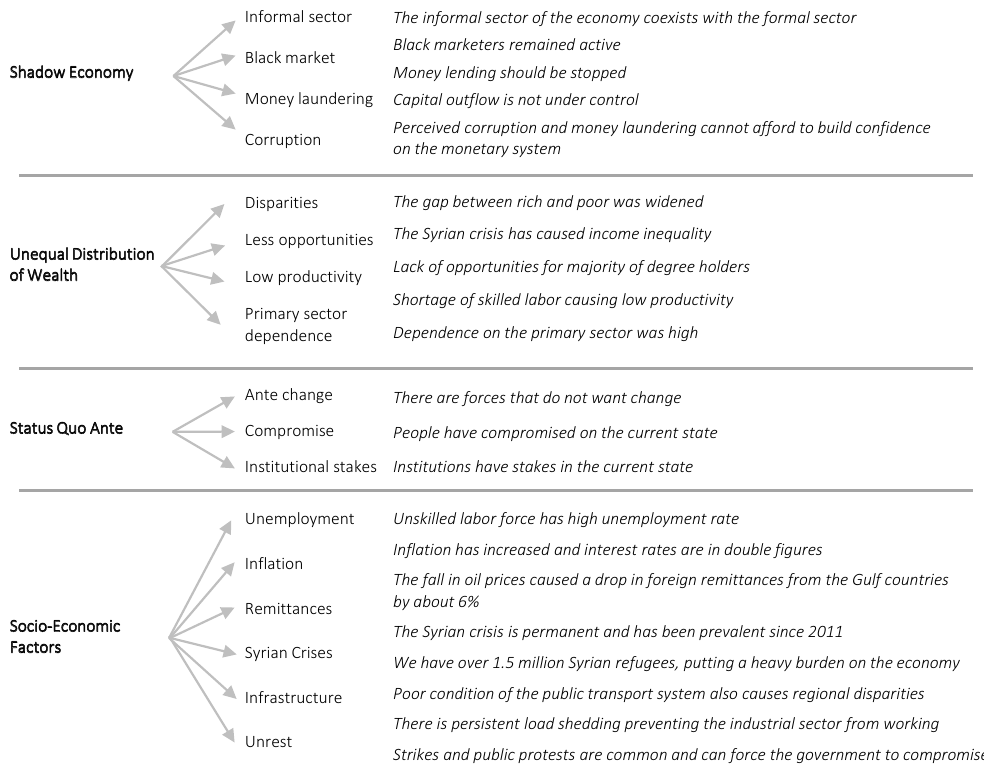
Figure 5. Thematic construct of Inherited Characteristics of the